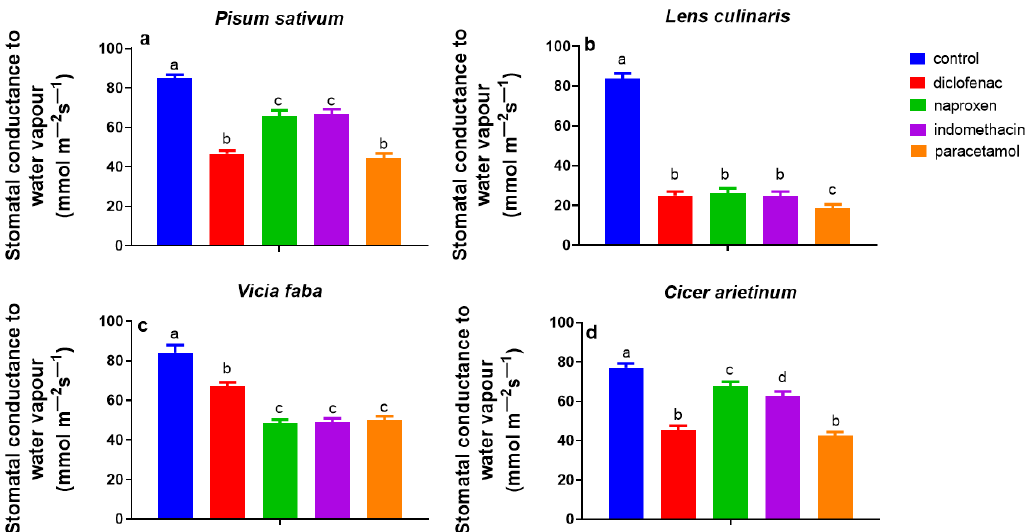
Figure 2. Stomata conductance to vapor water from Pisum sativum ( a ), Lens culinaris ( b ), Vicia faba ( c ), and Cicer arietinum ( d ). Plants in 0.5 L pots filled with commercial garden soil were treated by watering 100 mL of 0.5 mg L − 1 NSAIDs every second day over a total of 20 days. The values are averages of four independent measurements. Data sharing different letters are significantly different ( p < 0.05), while data sharing the same letters are not significantly different ( p > 0.05). 3.2. The Emission of Volatile Organic Compounds from Plants for Plants Affected by NSAIDs The plants from the Fabaceae family are not monoterpenes emitters in physiological conditions. There is a low emission of monoterpenes from plants under NSAID stress with no clear trend regarding drug type (Figure 3). The limonene is dominant in emission for all species, while camphene and β -ocimene show the lower emission.